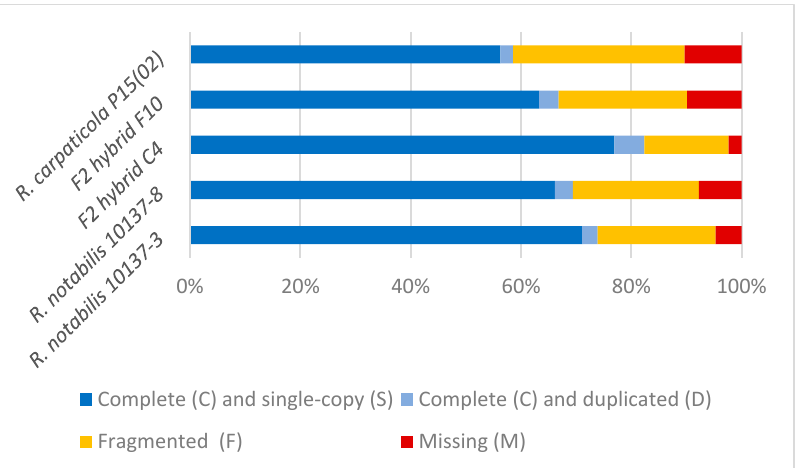
Figure 1. Summary of Benchmarking Universal Single-Copy Orthologues (BUSCO) analysis results for the assembled transcriptomes of the five studied individuals against the Viridiplantae BUSCO dataset. Total number of analysed BUSCOs: 425. Complete BUSCOS (C) [=Complete and single- copy BUSCOs (S) + Complete and duplicated BUSCOs (D)], Fragmented BUSCOs (F), Missing BUSCOs (M).